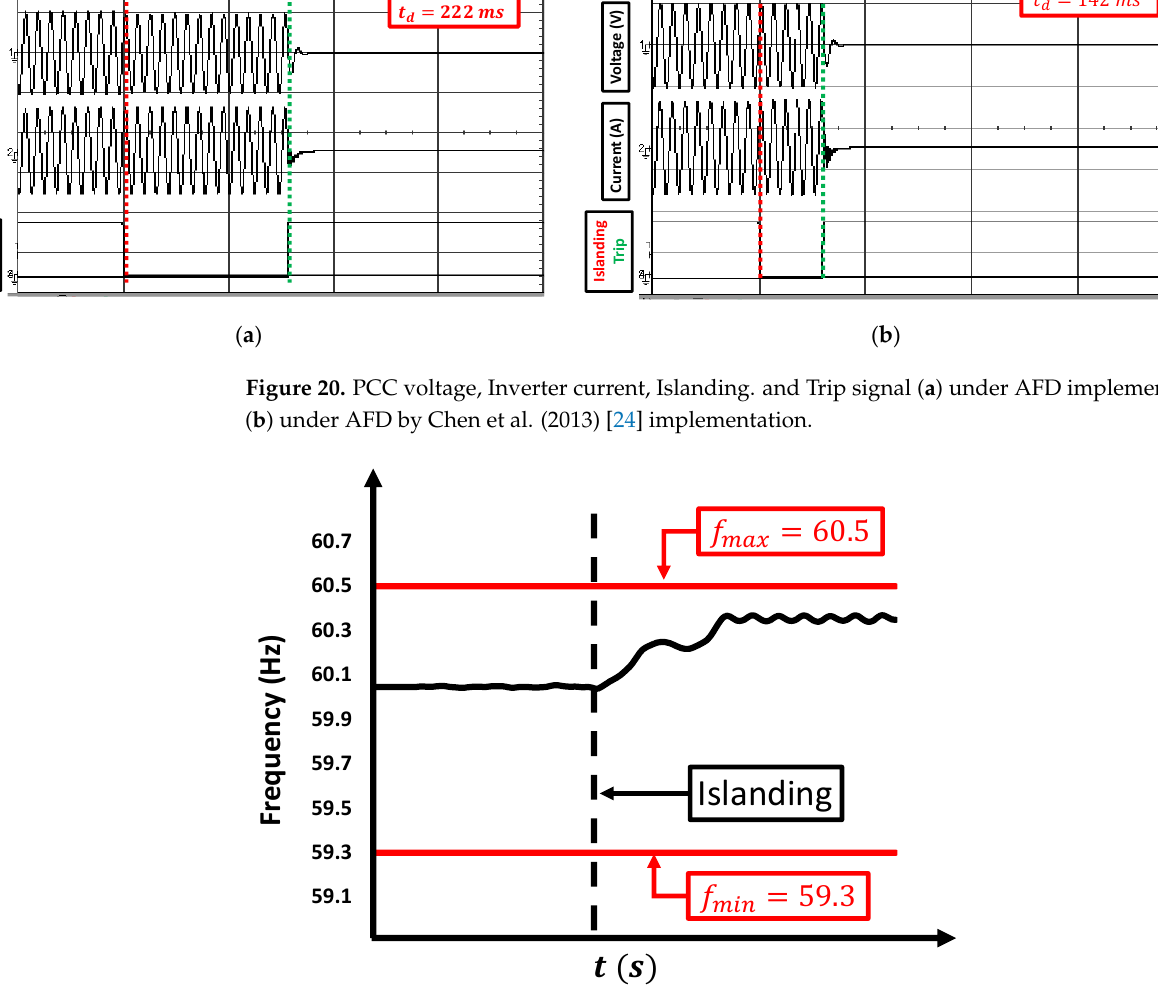
Figure 21. Frequency behavior after the Classic AFD implementation for the C norm =